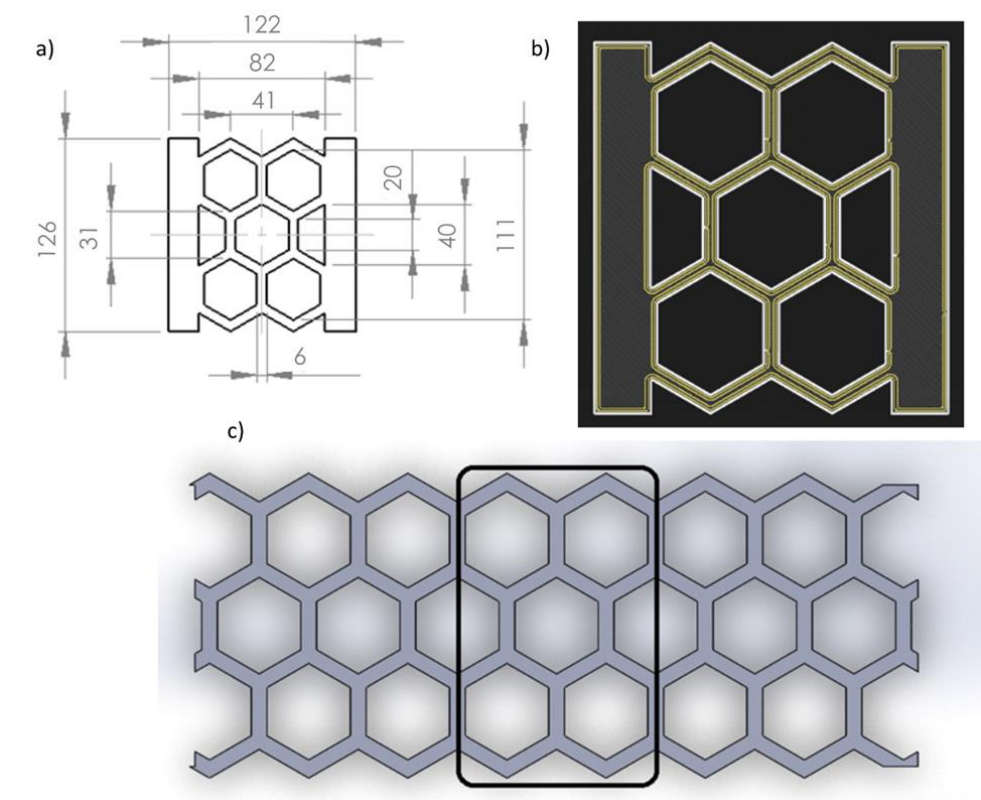
Figure 2. ( a ) Technical drawing of the designed honeycomb structure as specimen; ( b ) honeycomb structure in Eiger™ Software, by Markforged; and ( c ) extended honeycomb structure.